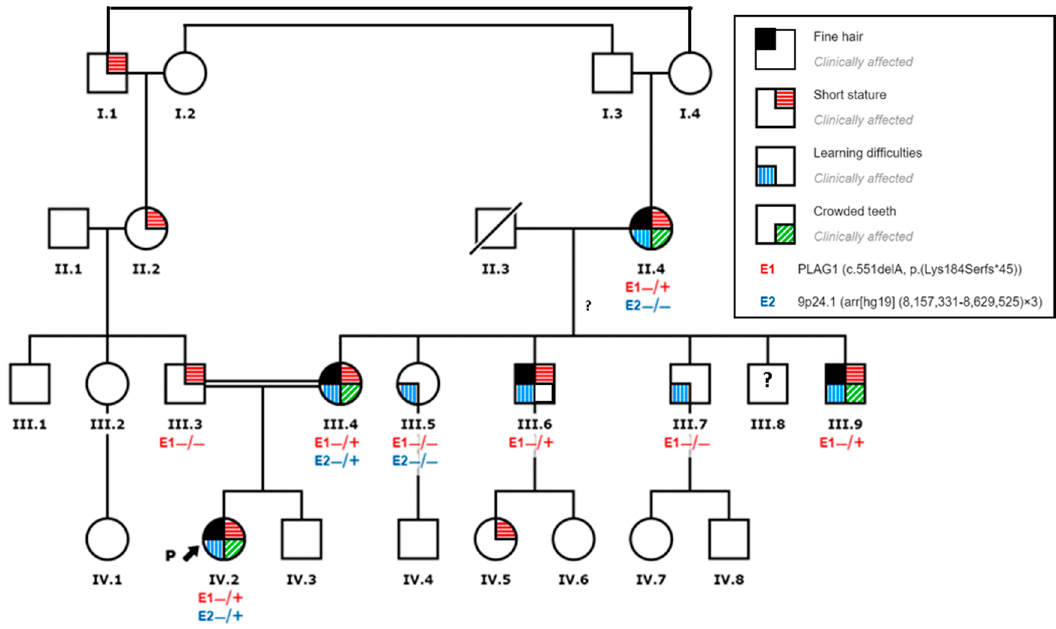
Figure 2. Family pedigree: the arrow points to the index case. The family members carrying the variant are represented as (+/ − ) versus non-carriers ( − / − ). The presence of each feature is represented by a colored square.